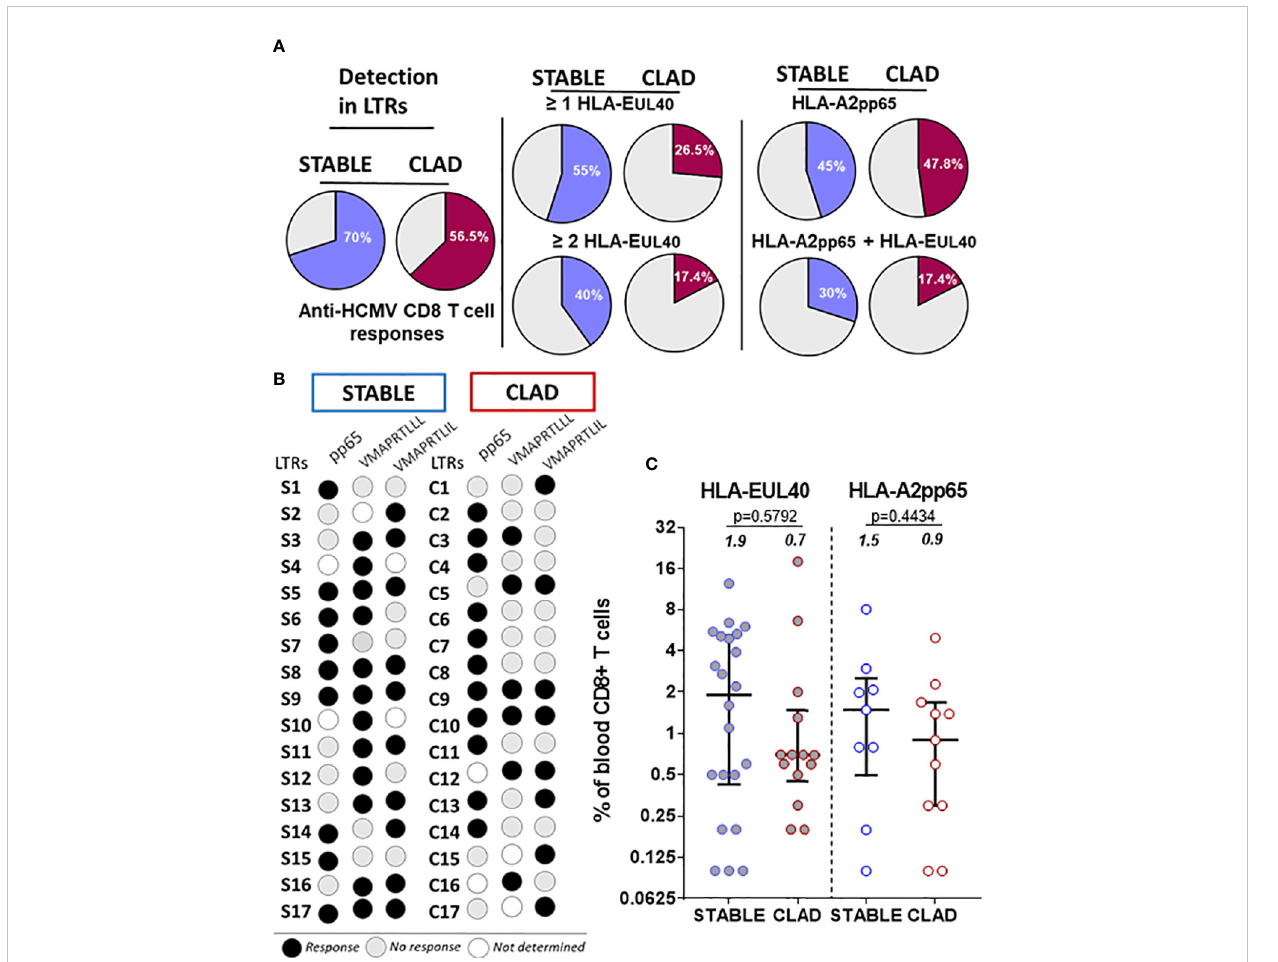
FIGURE 2 Detection and frequency of HLA-A2pp65 and HLA-E/UL40 human cytomegalovirus (HCMV)-speci fi c CD8 T cells in chronic lung allograft dysfunction (CLAD) versus STABLE LTRs. (A) Pie charts indicating the percentages of HCMV + LTRs with HCMV-speci fi c CD8 T cells detected at M18 post-transplantation. A single PBMC sample per STABLE (in blue, n = 32) and CLAD (in red, n = 31) LTRs was used for the concomitant detection of HLA-A2pp65 and HLA-EUL40 CD8 T cells. For the detection of HLA-EUL40 CD8 T cells, two HLA-E tetramers loaded with two different peptides (VMAPRTLLL and VMAPRTLIL) corresponding to the most frequent UL40 variants were used in parallel experiments. The percentages of hosts with at least one type of CD8 T-cell response (A2pp65 or EUL40, left panel) and at least one or two EUL40 CD8 T-cell responses (central panel) with only an A2pp65 response or with both A2pp65 and EUL40 CD8 T-cell responses (right panel) are shown. (B) Schematic representation illustrating the patterns of peptide speci fi cities for the anti-HCMV CD8 T cells detected in the STABLE and CLAD HCMV + hosts. In both groups (STABLE and